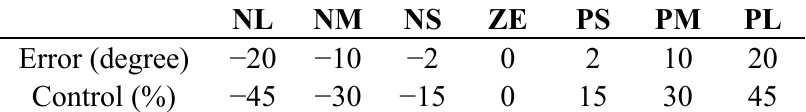
Table 3. Pitch Rule Inference.